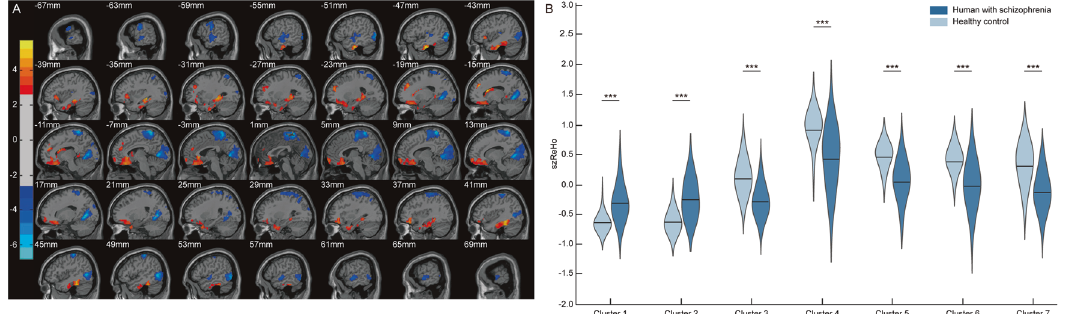
Fig. 2 Frontal-posterior functional imbalance in hSZ. A Frontal-posterior functional imbalance was found in hSZ compared to HC, expressing as decreased posterior (primary sensory cortices) and increased frontal (higher order frontal cortices) ReHo. B ReHo value was extracted from signi fi cant clusters identi fi ed in the voxel-based test of hSZ vs. HC. Frontal-posterior functional imbalance illustrated as increased frontal ReHo to decreased posterior ReHo from Cluster 1 to Cluster 7. A Signi fi cant at voxel P < 0.01, cluster P < 0.05 corrected by GRF correction; B signi fi cant at P < 0.05, * P < 0.05, ** P < 0.01, *** P < 0.001. SZ schizophrenia, hSZ human with schizophrenia, HC healthy control, ReHo regional